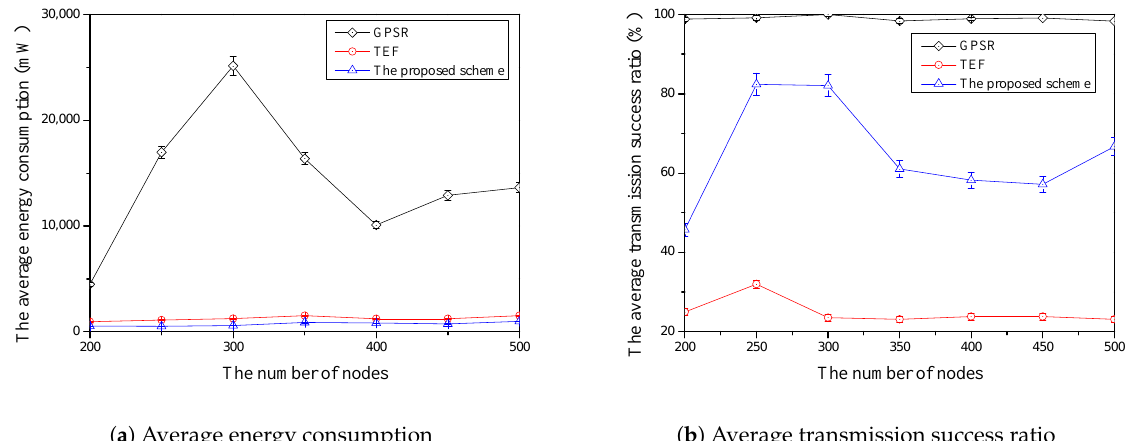
Figure 7. The comparison of the average energy consumption (Figure 7a) and the average transmission success ratio (Figure 7b) according to the number of